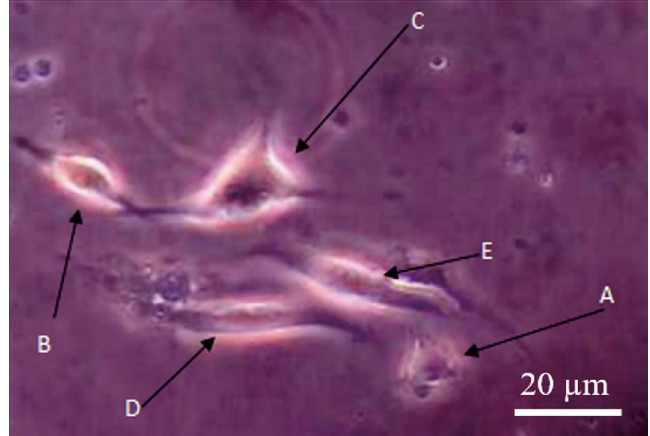
Figure 1. Nerve cells observed in medium culture: (A) Apolar; (B) Bipolar; (C) Multipolar; (D and E) undiffer-